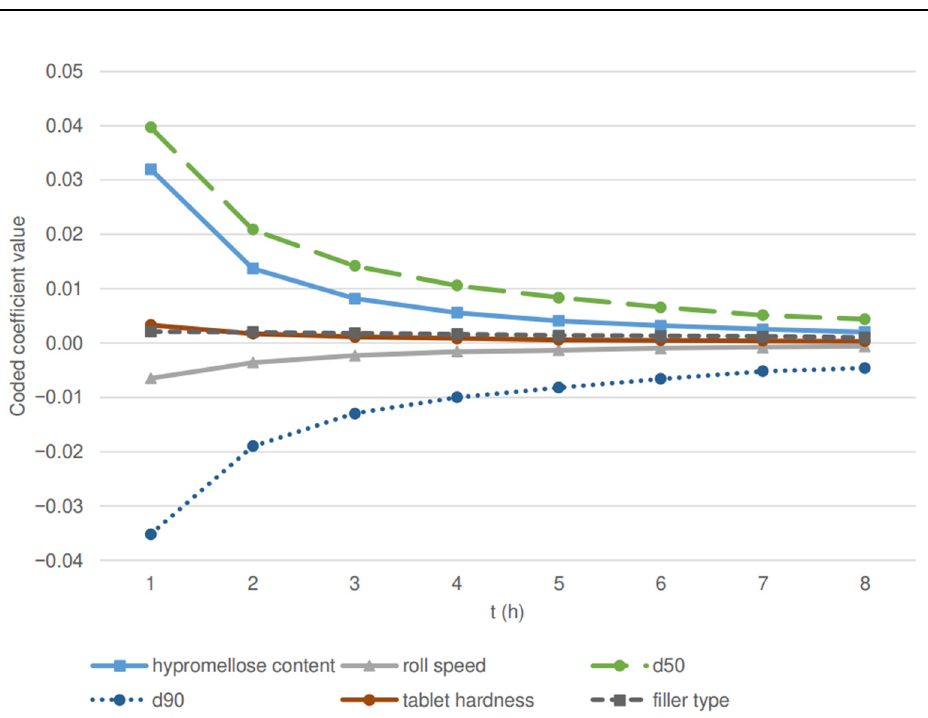
Figure 1. Time dependence of coded coefficients of predictive models for significant factors (hypromel- lose content, filler type, roll speed, d50, d90, and tablet